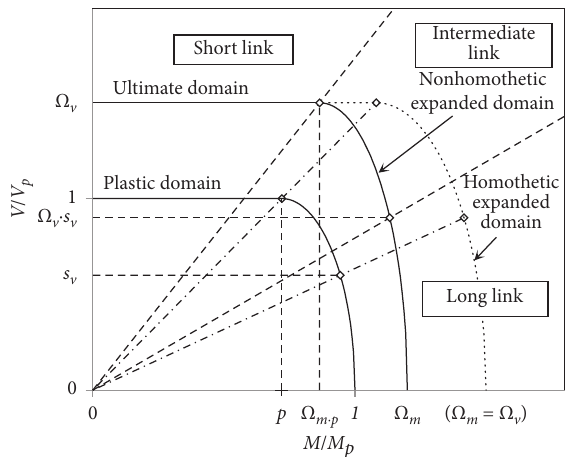
Figure 2: Moment-shear interaction diagram ( p � M